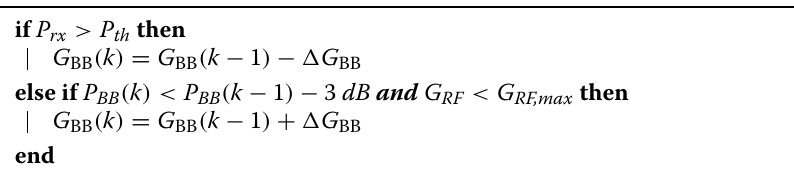
Algorithm 1: Automatic gain control